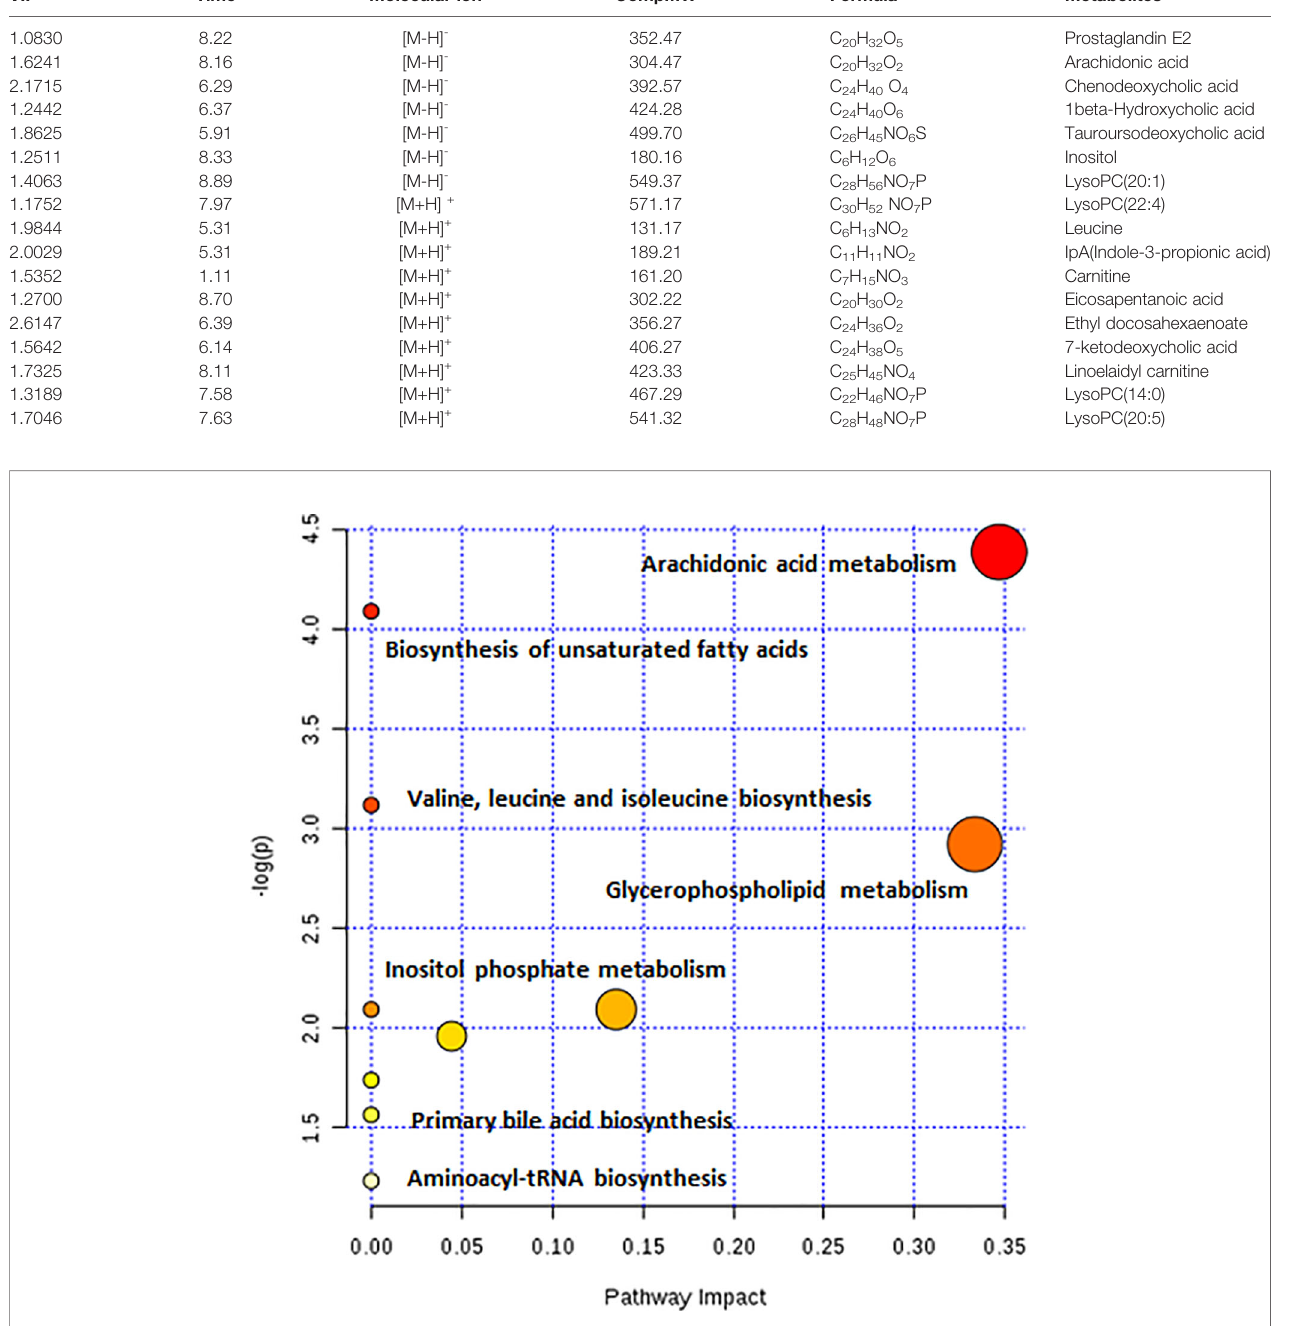
FIGURE 5 | Main pathway analysis associated with metabolites that were in fl uenced by